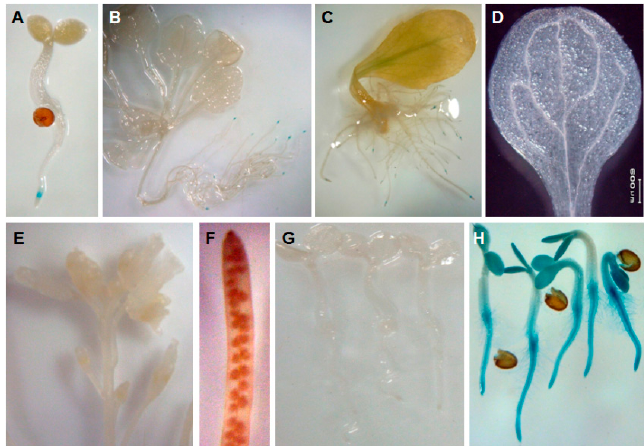
Figure 2. Gene expression pattern of AtTGG4 Prom::GUS . ( A ) A four-day-old seedling; ( B ) a two-week-old plant; ( C ) roots induced from the petiole of a leaf showing root-tip specific GUS staining; ( D ) a leaf; ( E ) an inflorescence; ( F ) a silique; ( G ) wild-type (negative control); and ( H ) transgenic plants with CaMV 35S::GUS (positive control).